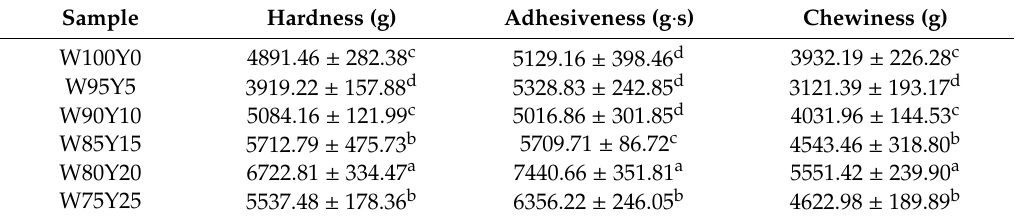
Table 2. E ff ects of yam flour addition on texture properties of mixed flour